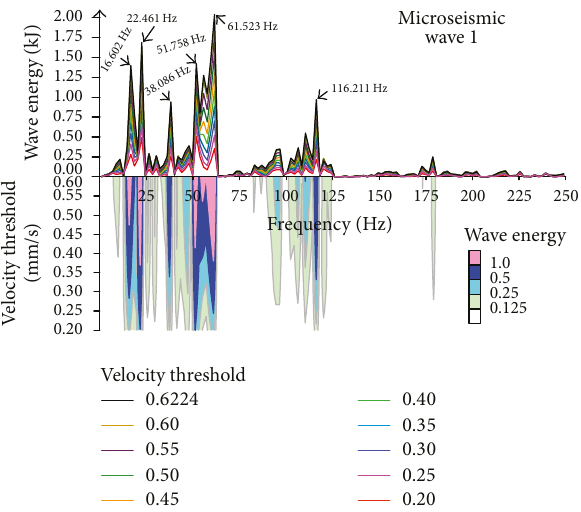
Figure 9: Changes of wave energy in frequency range with the increase of velocity